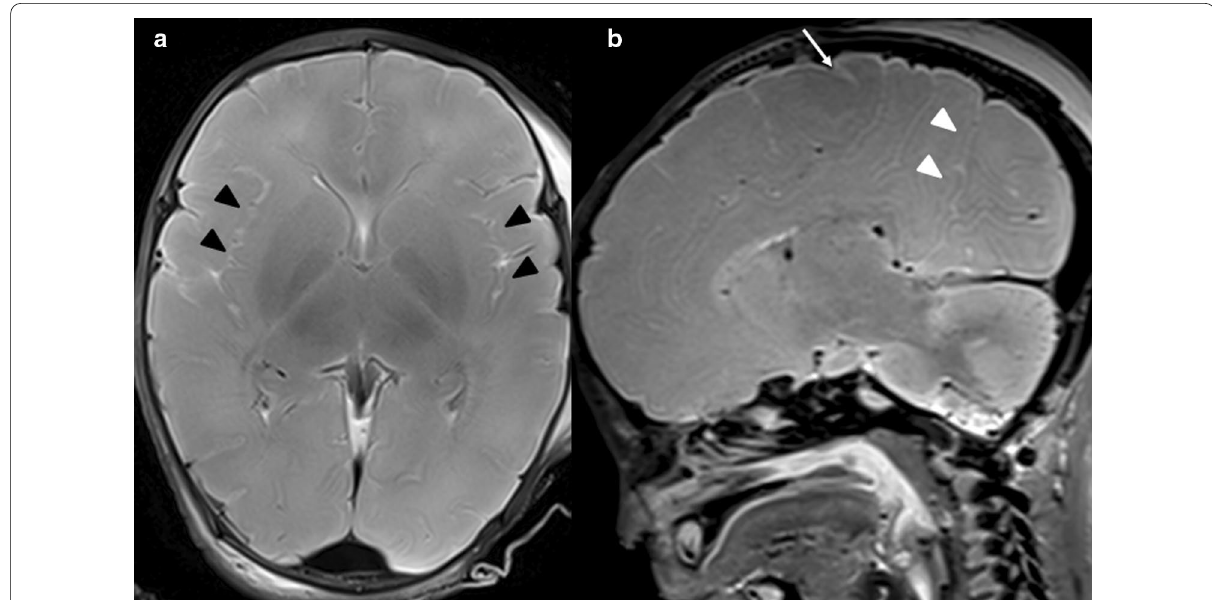
Fig. 2. 36‑week foetus with normal cerebral sulcation. a Axial T2‑weighted image shows normal Sylvian fissure (black arrowheads). b Sagittal T2‑weighted image shows normal parieto‑occipital fissure (white arrowheads) and central sulcus (white arrow)